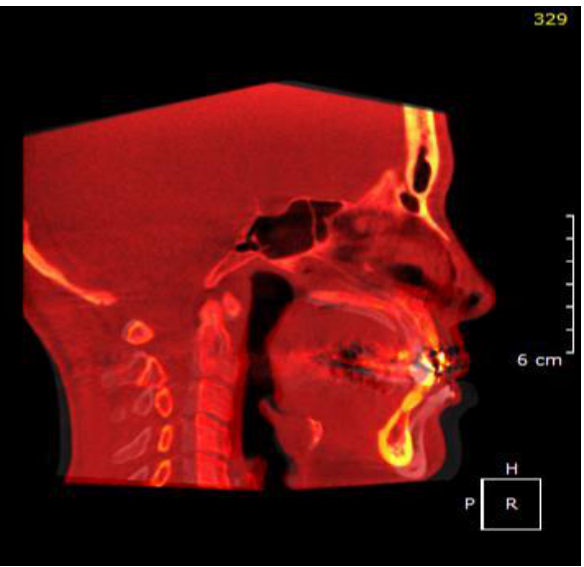
Figure 6. An overlay of the patient’s pre-surgery and post-surgery CT images. This shows the movement of the maxillomandibular complex.